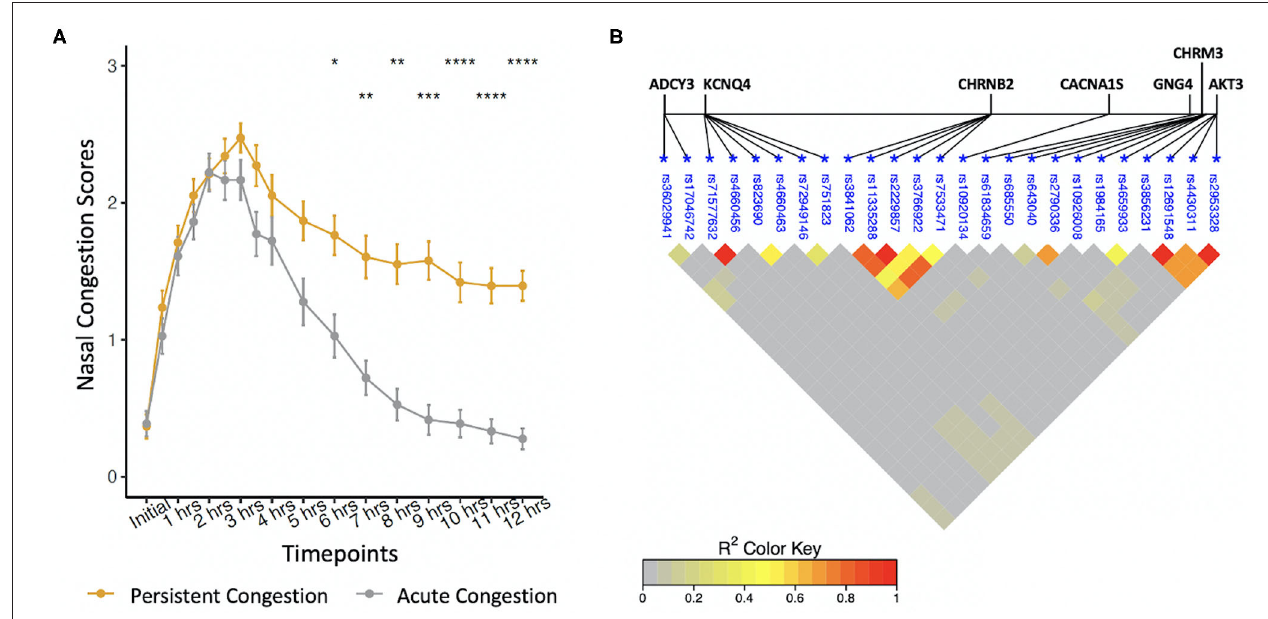
FIGURE 1 | (A) Phenotyping of self-reported nasal congestion scores over a 12-h period from the start of allergen exposure. Significant differences were found between the sub-phenotypes at hours 6–12. * P < 0.1, ** P < 0.01, *** P < 0.001, **** P < 0.0001, Wilcoxon Signed Rank test with Bonferroni corrections. (B) Linkage disequilibrium between polymorphisms associated with the late-phase